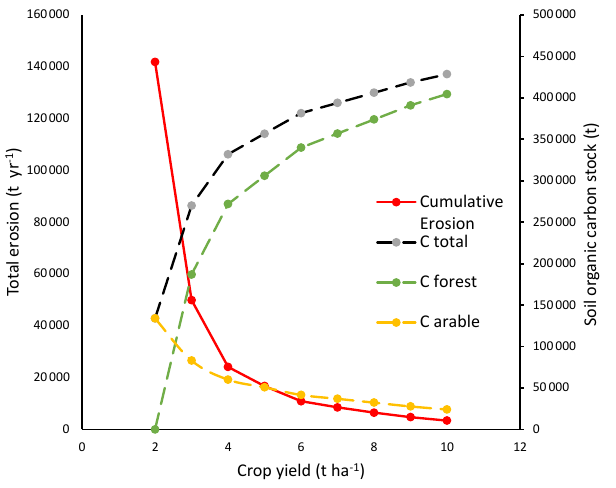
Figure 4. Frequency distribution of experimentally observed car- bon sequestration rates under agroforestry. Data from 18 paired field studies in both (sub)tropical and temperate climates (details and references of studies in Govers et al., 2013). The average soil organic carbon sequestration rate reported over all 18 studies is 0.25 ± 0.33tha − 1 yr − 1